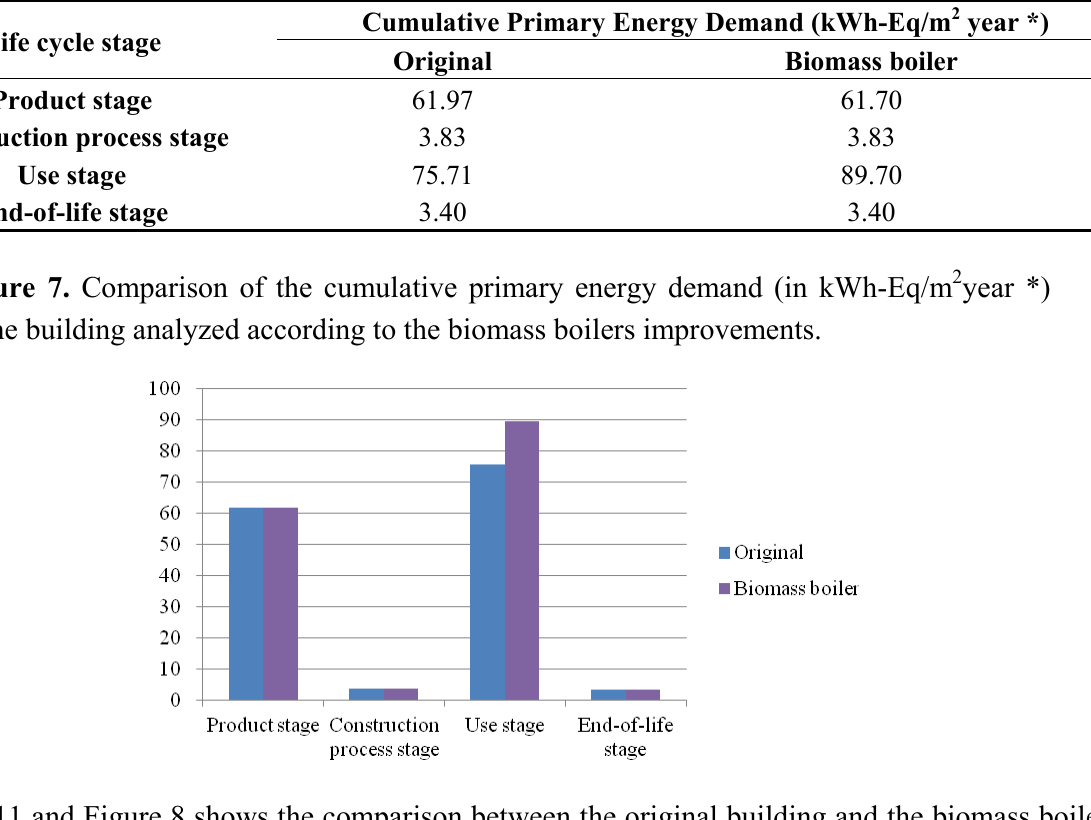
Table 10. Numerical comparison of the cumulative primary energy demand (in kWh-Eq/m 2 year *) in the building analyzed according to the biomass boiler improvement.